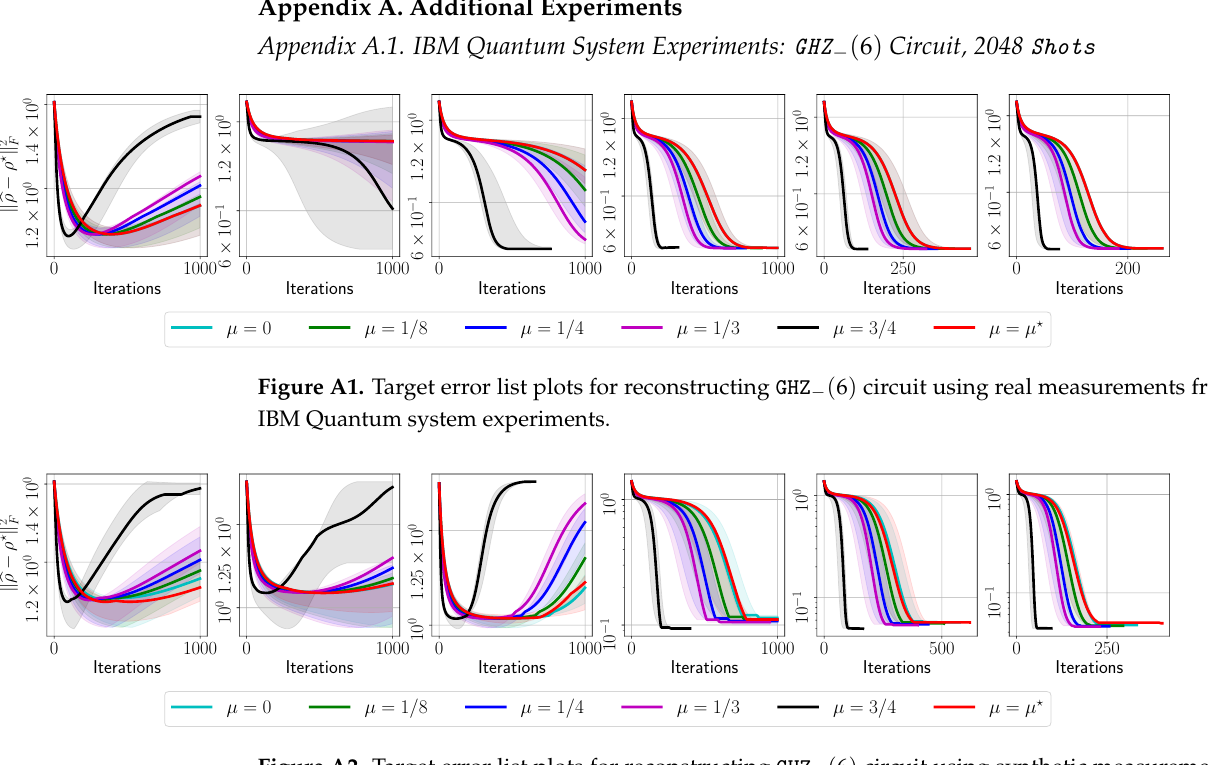
Figure A2. Target error list plots for reconstructing GHZ from IBM’s quantum